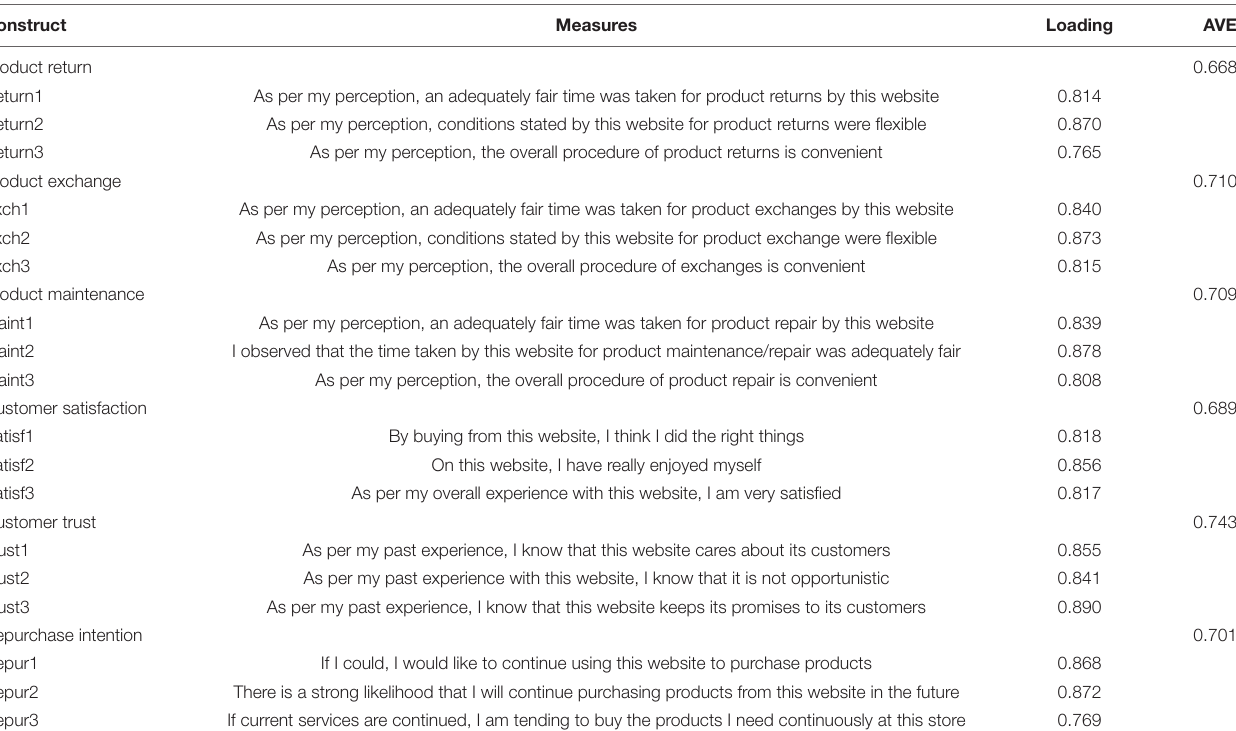
TABLE 4 | Convergent validity.